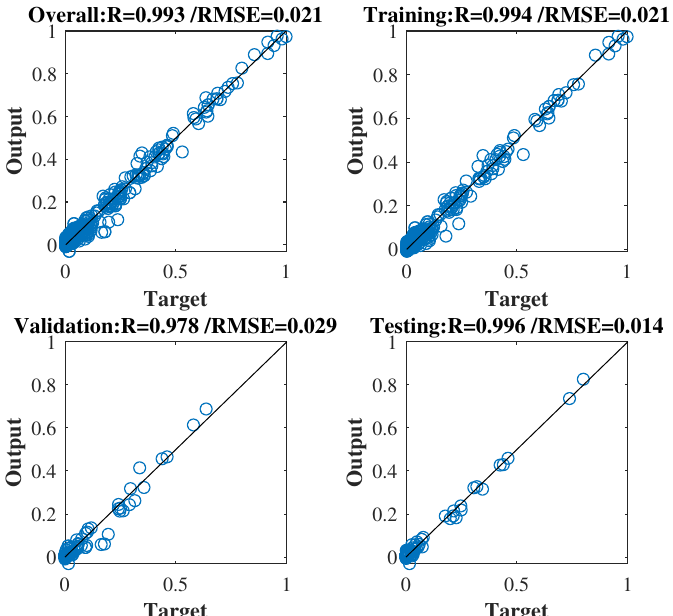
Figure 8. Regression of the original data (Target) and the predicted data (Output) for all data (overall), and for each of the training, validation, and testing